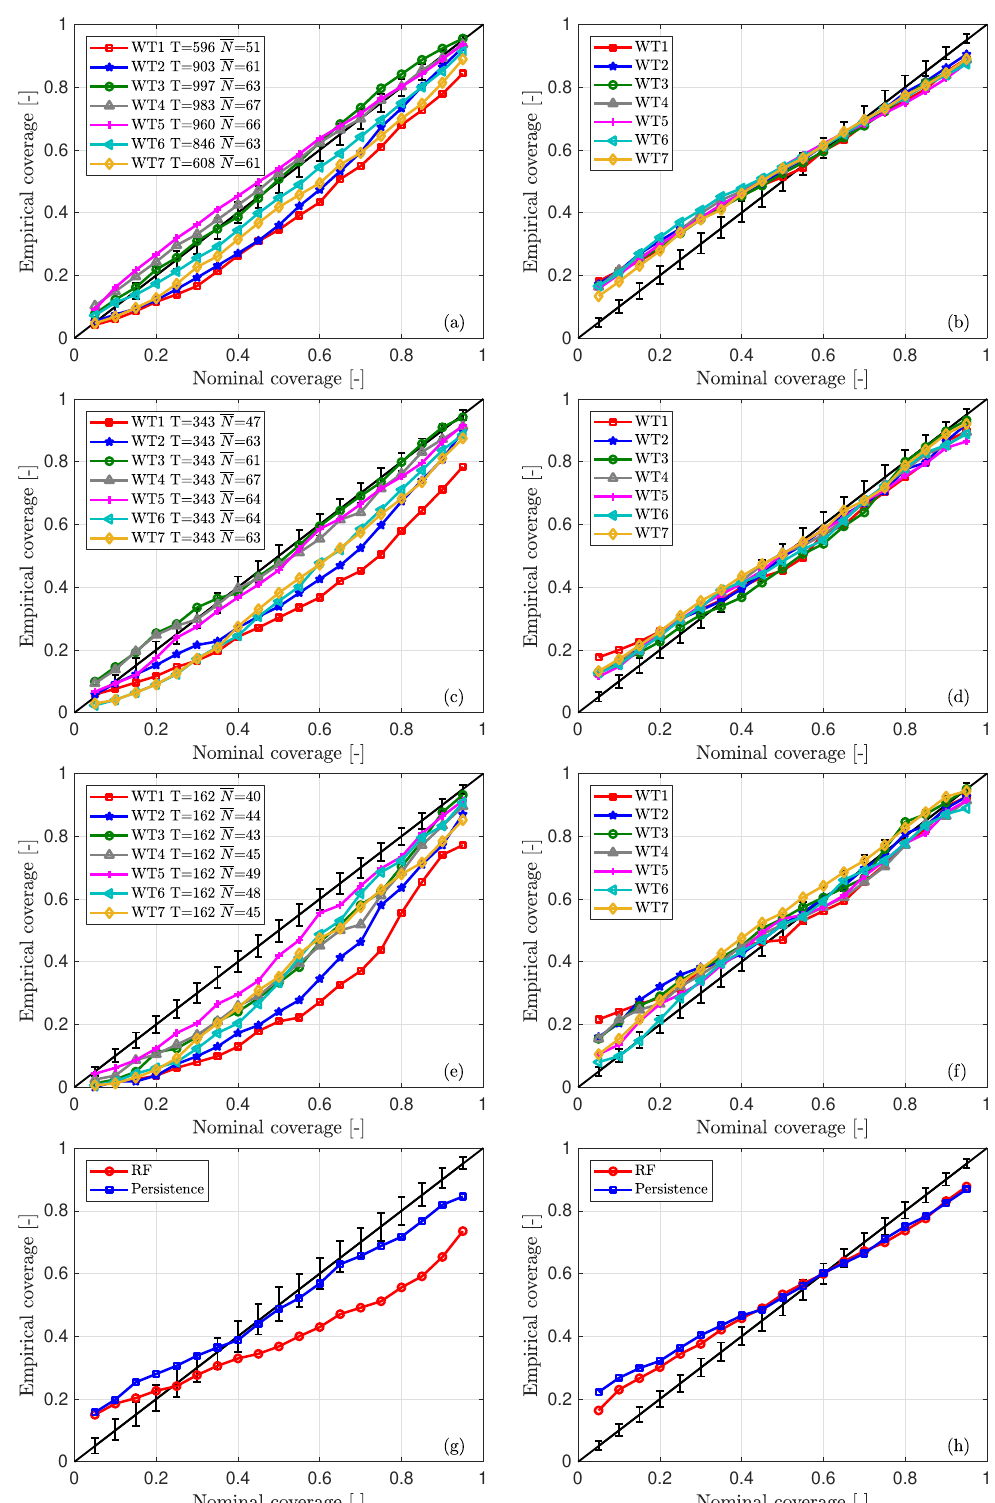
Figure 11. Reliability diagram for all wind turbines (WTs) during available measurements ( T ) for ( a ) the remote sensing-based forecasting model (RF) and ( b ) persistence model, simultaneous periods for ( c ) the RF and ( d ) persistence model, a reduced radar availability case for ( e ) RF and ( f ) persistence model and ( g ) the aggregation of WT 1 to WT 7 and ( h ) WT 3 to WT 5 for both models. N indicates the average number of wind field vectors conforming the wind speed distributions of the RF model. In addition, 95% consistency bars are indicated by the error